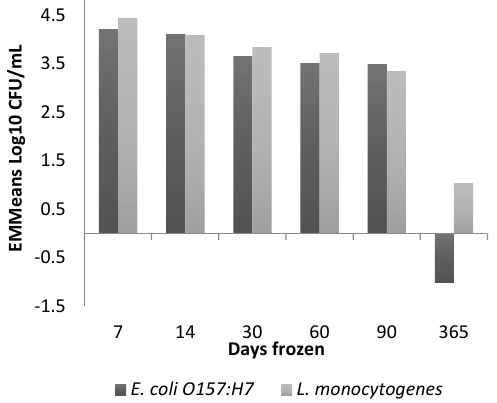
Figure 5. EMMeans of E. coli O157:H7 and L. monocytogenes concentrations after freeze/thaw effects and days of frozen storage. Adjusted for the covariate of mean pathogen concentration at baseline.